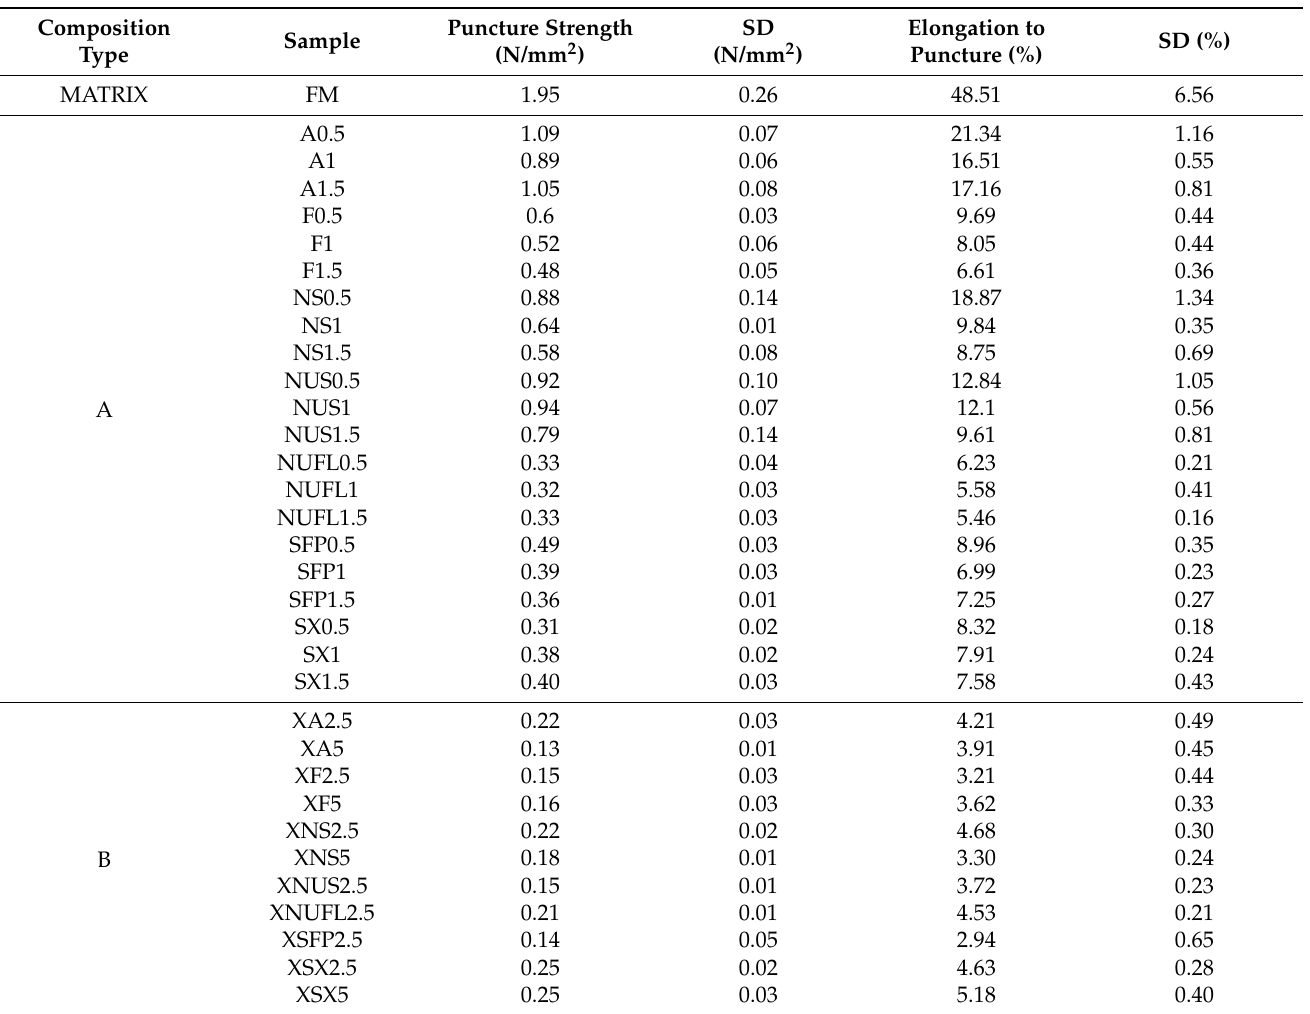
Table 4. Results of puncture